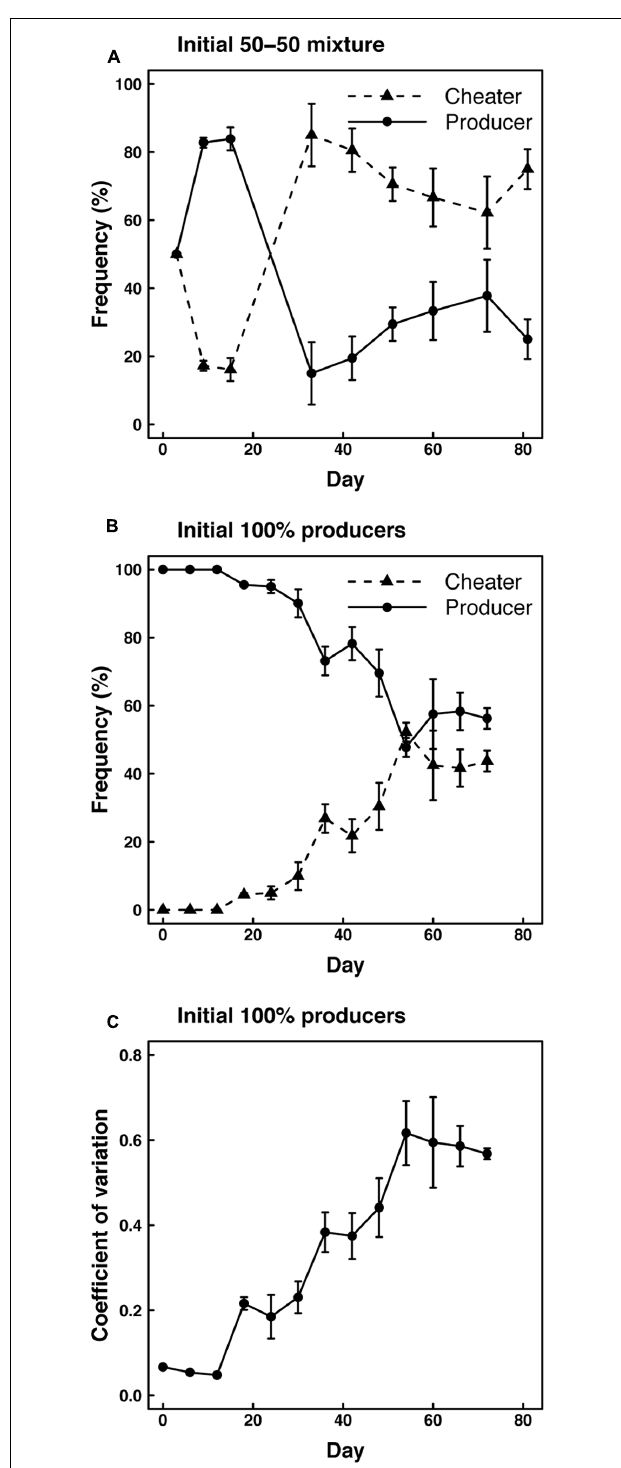
FIGURE 3 | Frequencies of cheaters and producers based on protease expression in experiments with (A) cheaters and producers (50–50%) or only producers (B) initially inoculated onto agar plates. (C) Coefficient of variation in protease expression level based on clones isolated from the agar plates inoculated with producers